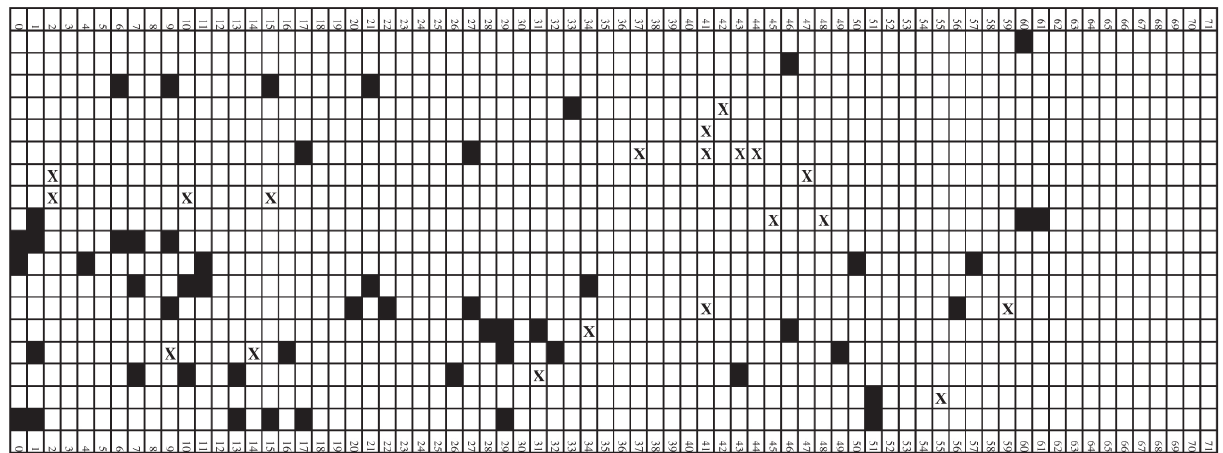
Fig. 2. Two-dimensional class analysis matrix for the cumulative values in the study plot. Black squares - SCFs (standard count frequencies) significantly greater than expected (SCFs + = 53); X signed squares - SCFs significantly less than expected (SCFs - = 20); white squares indicate [X,Y] distance classes with SCFs as expected. As the propor- tion of significant SCFs is less than 0.05 this matrix represents a random data set.